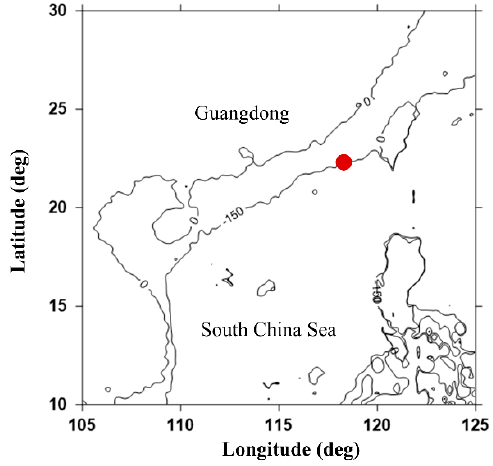
Figure 14. The hypothetical deployment site of the WSA.